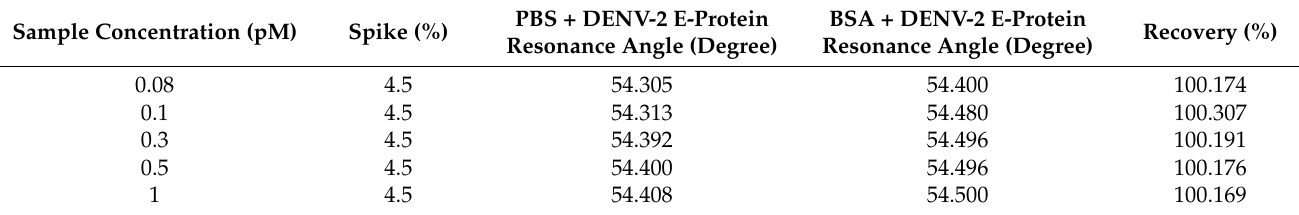
Table 3. Spike and recovery results of DENV-2 E-proteins in